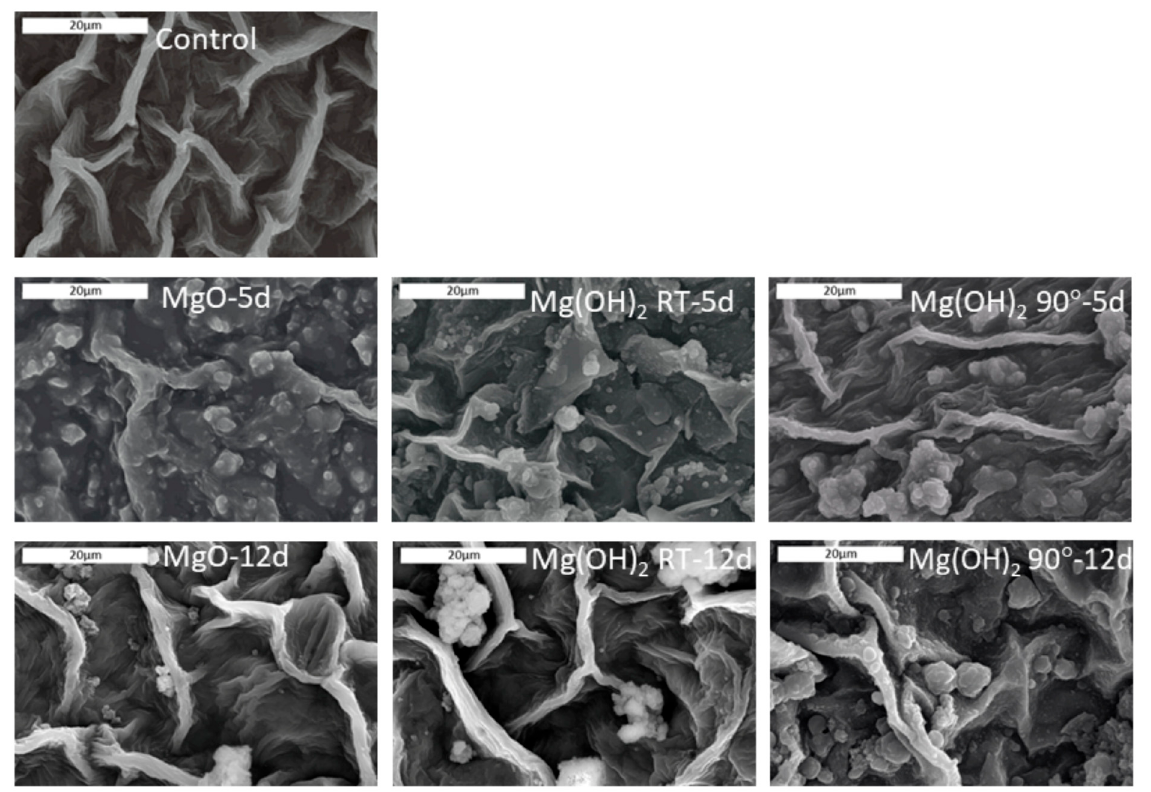
Figure 6. SEM images of the leaves of the control plant (H 2 O) and the plants sampled on day 5 (5 d) and day 12 (12 d) for PMP-1, PMP-2, and PMP-3. The scale bars correspond to 20 μ m.